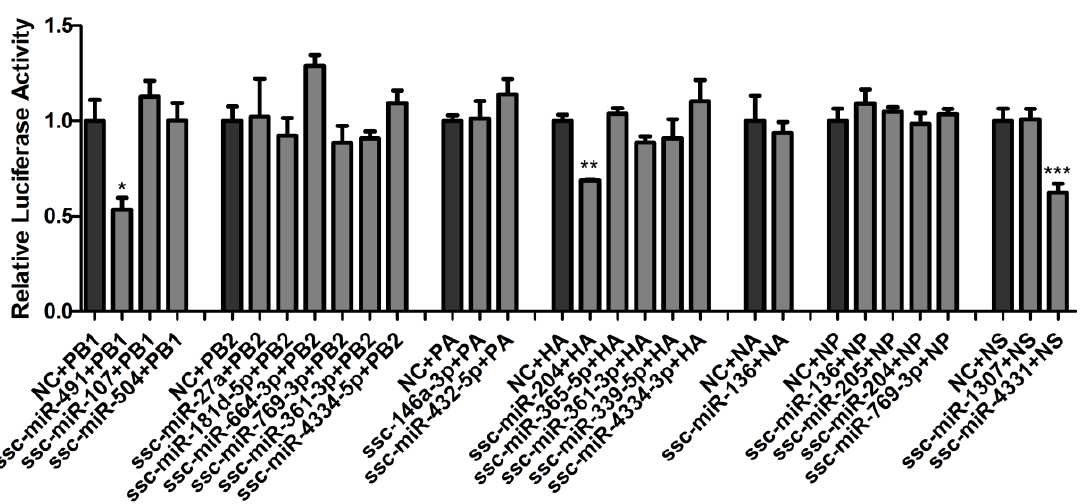
Figure 1. Overall validation of potential miRNAs targeting SIV-H1N1/2009 genomic RNA by dual-luciferase reporter arrays. Seven genes of SIV-H1N1/2009 were cloned into the luciferase reporter vector pmirGLO and then cotransfected with their corresponding predicted miRNA in newborn pig trachea (NPTr) cells. The cells were harvested for assaying luciferase activity at 24 h post-transfection. The pair of ssc-miR-491 and PB1 was considered as the positive control. Data were shown as relative firefly luciferase activities normalized to the value of renilla luciferase. Significant levels were analyzed by Student’s t -test, * p ≤ 0.05, ** p ≤ 0.01, *** p ≤ 0.001. NC: negative controls.